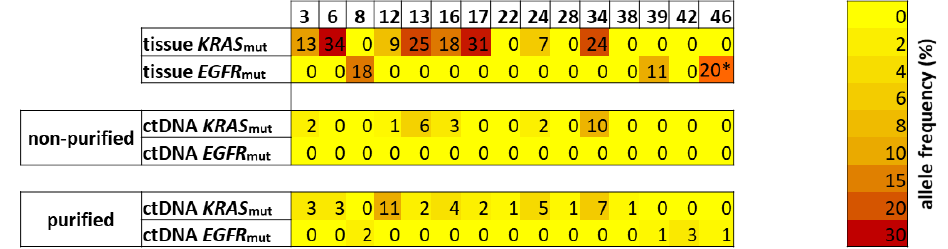
Figure 7. Decreased allele frequency in non-purified ctDNA samples. Heatmap showing the variant allele frequency (%) of detected oncogenic mutations in purified and non-purified ctDNA in comparison to the detected mutations using tissue biopsies (*estimated from Sanger sequencing).